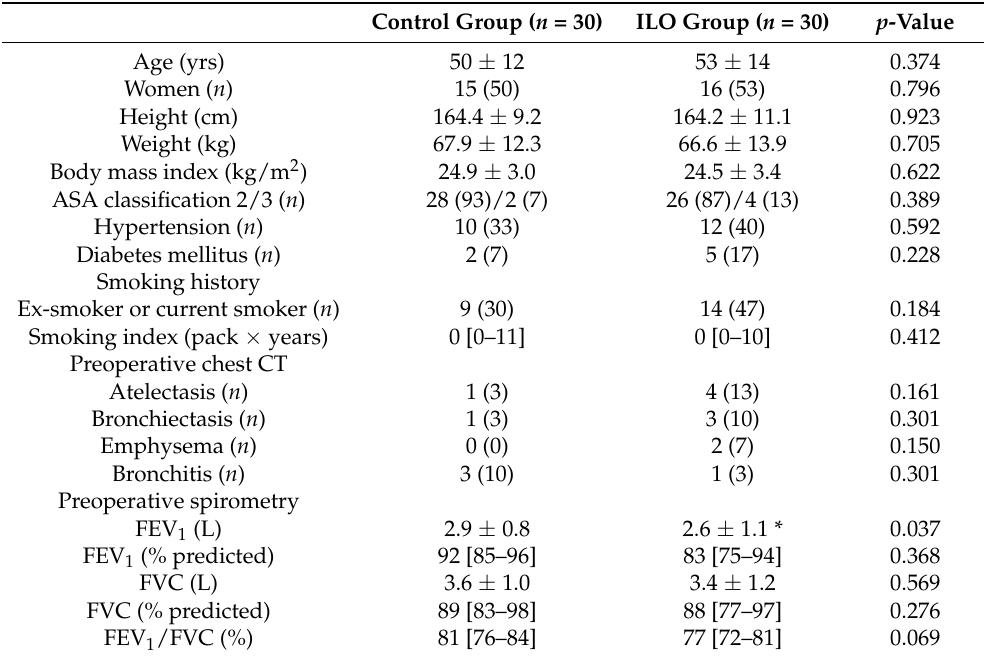
Table 1. Preoperative data.